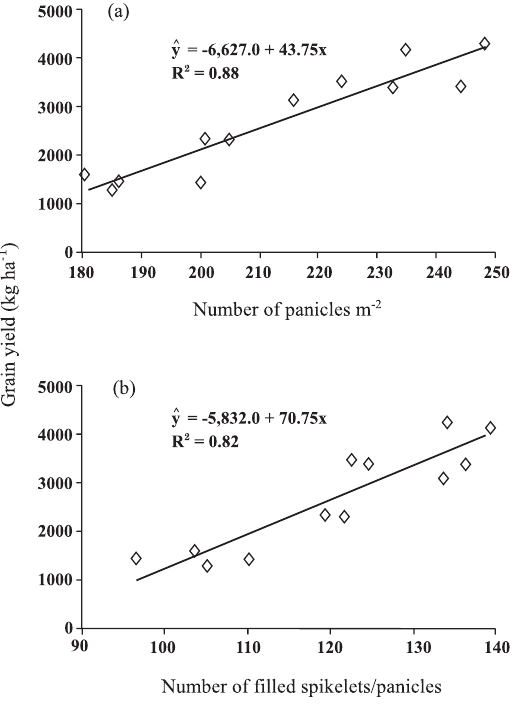
figure 7. grain yield as a function of the number of panicles m -2 (a) and number of filled grains per panicle (b).